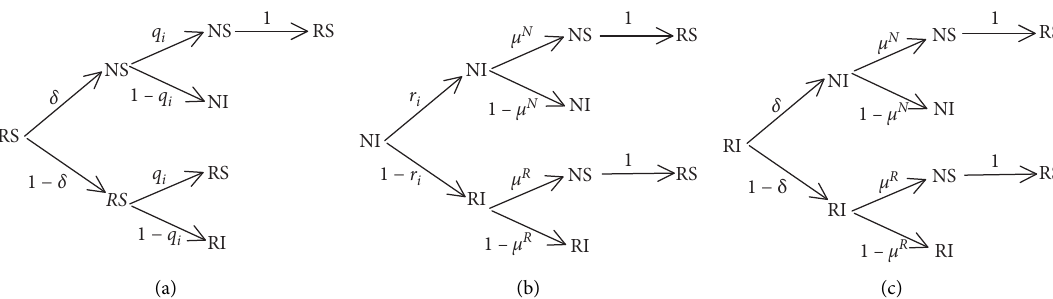
Figure 2: Transition probability trees of three types of nodes. They describe the transient changes of nodes’ states at each time. The definitions of parameters can be found in Table